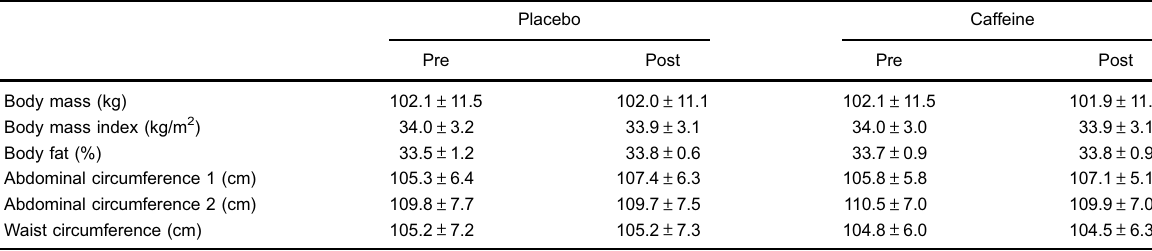
Abdominal circumference 1 was measured at half distance between the xiphoid process and umbilical scar. Abdominal circumference 2 was measured at the umbilical scar. Data are reported as means ± SD, for n=14. There were no signi fi cant differences between conditions or between pre- and post-intervention (P 4 0.05,